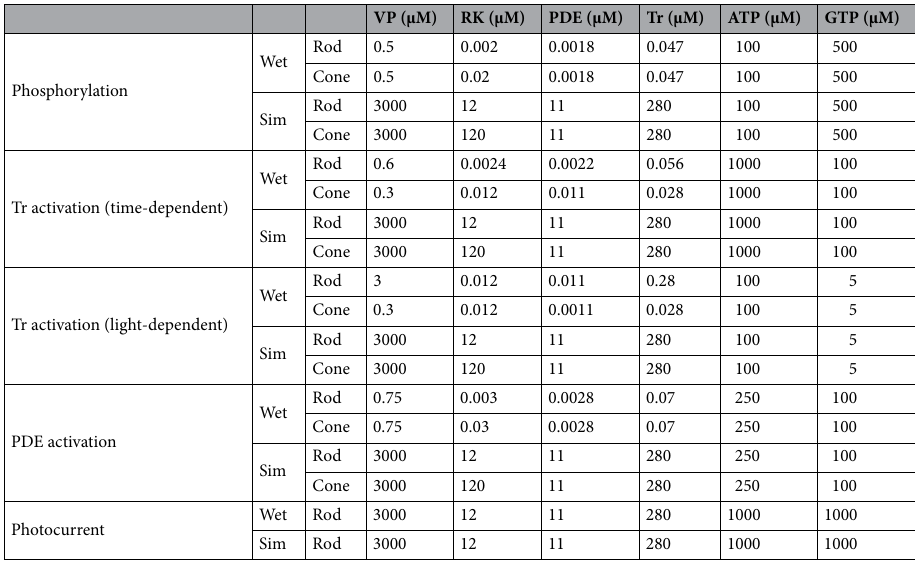
Table 1. Parameters of the membrane-associated molecules applied for simulation in comparison to these estimated in the experimental studies. Wet column represents in vitro substrate concentrations calculated after taking into consideration the experimental test tube volume, while Sim. refers to physiological in vivo concentrations 8 . The Sim. values were applied for the simulation experiments assuming that the in vivo disk membrane structures were preserved in the in vitro experimental environments so the membrane bound molecular concentrations w.r.t. rate constants becomes identical to the in vivo concentrations (see “Discussion” section for more